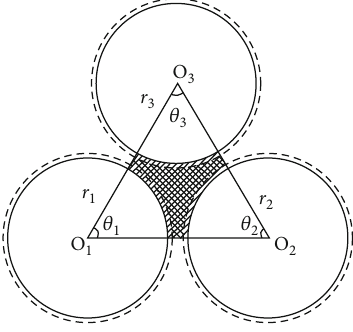
Figure 3: Schematic diagram of adsorption